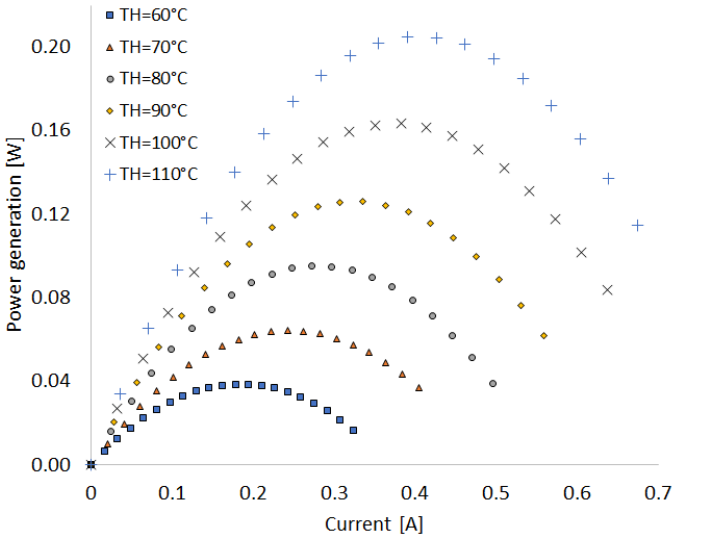
Figure 4. Experimental data for TEG output power P output for different hot side temperature condi- tions and constant T cold = 24.3 ◦ C.